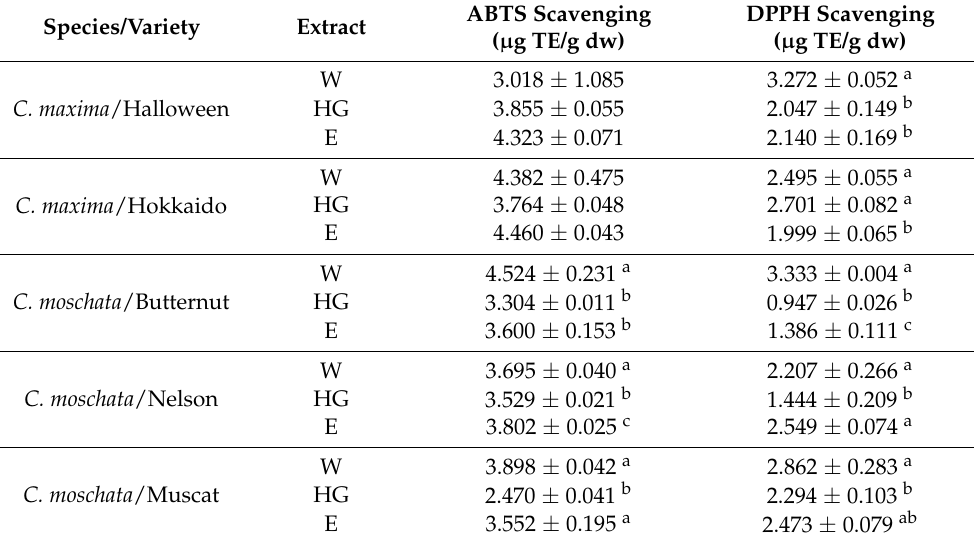
Table 7. DPPH and ABTS scavenging activities of Cucurbita spp. peel extracts. ABTS Species/Variety Extract